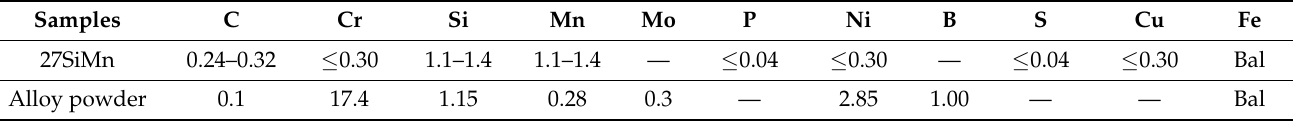
Table 1. Chemical composition (mass fraction, %) of laser cladding powder and matrix (27SiMn steel, wt%). Samples Alloy powder